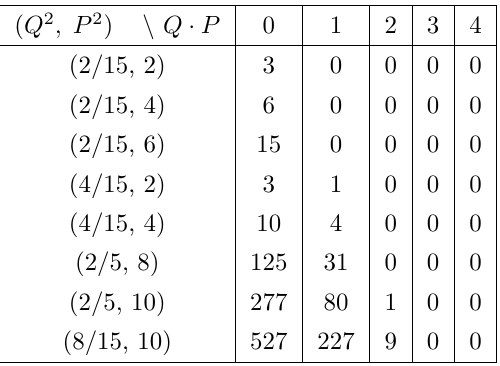
Table 13 . Index of horizon states for the 14 A orbifold of K 3 .